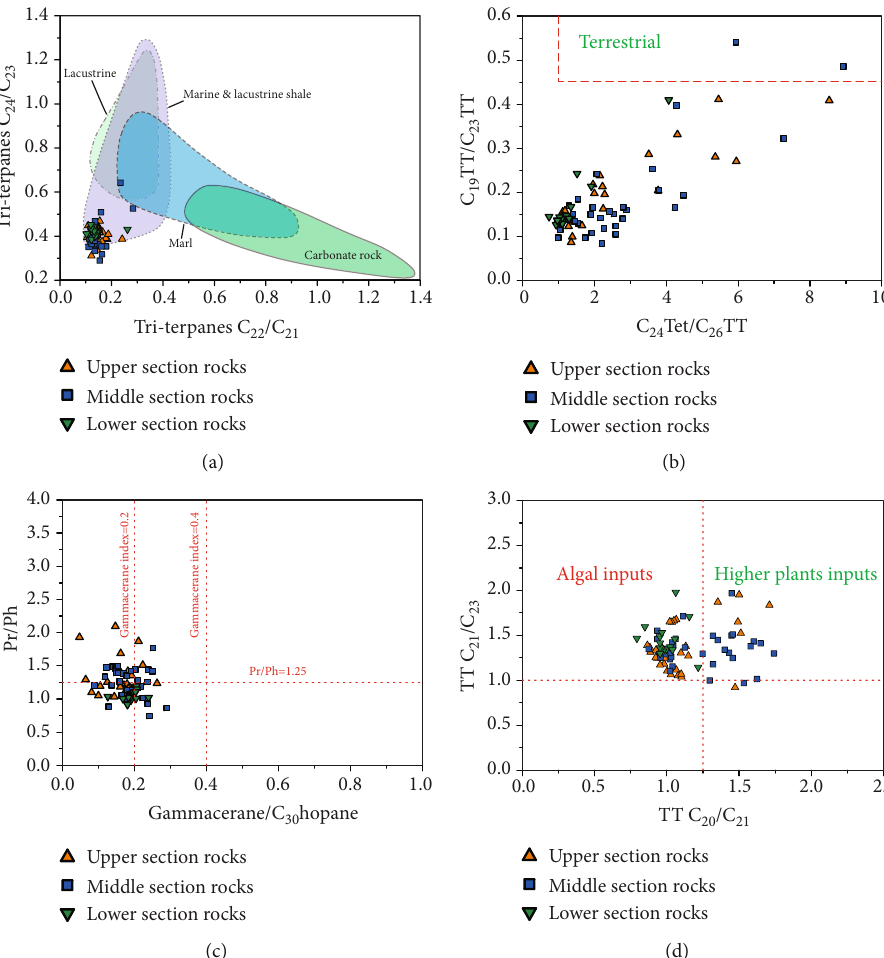
– C TT (tricyclic terpane) plot used to identify the depositional environment. (b) 21 24